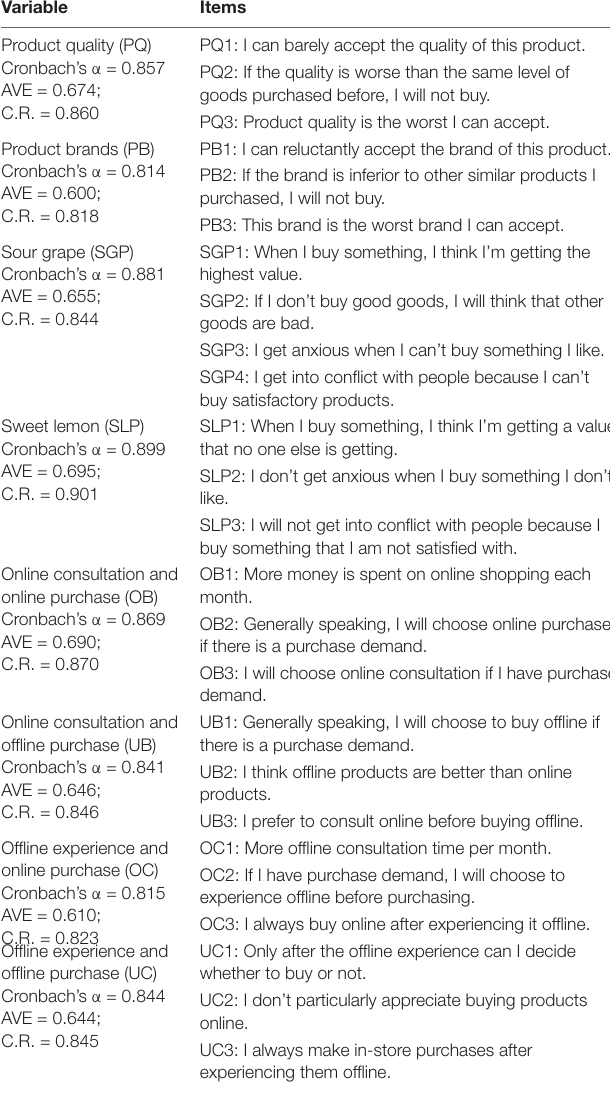
TABLE 1 | Questionnaire items and reliability test.